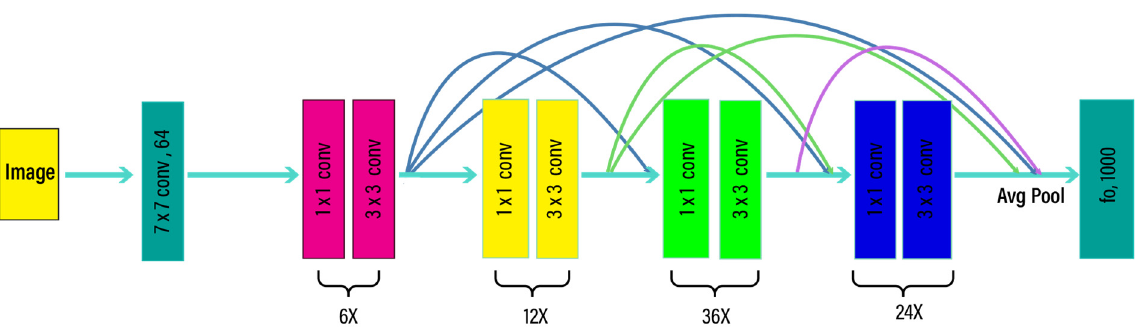
Figure 3. A block diagram illustrating the pretrained DenseNet-161 model.